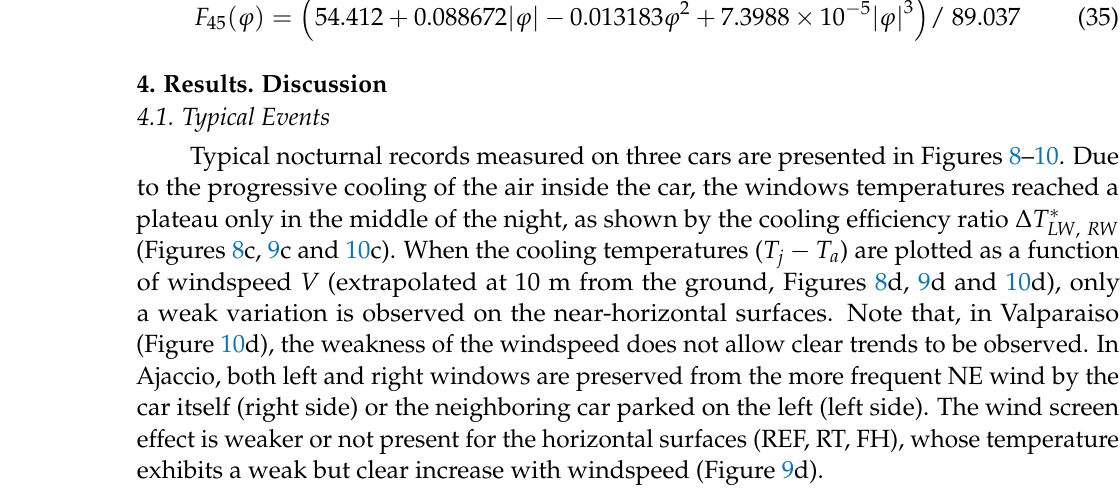
Figure 9. Recorded data for the reference condenser ( T 0 ) and rooftop and front hood on the AD car for the night 13 − 14 November 2020 (hh:mm:ss, UT + 1) in Ajaccio. ( a ) Differences with air temper-